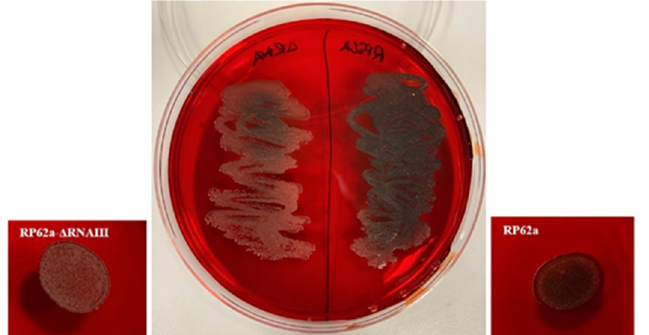
Figure 11. Verification of decreased polysaccharide production in EPS of RP62a- ∆ RNAIII (left) compared to RP62a (right) on Congo Red agar. Figure also compares change in results when culture is dropped and spread (center Figure).